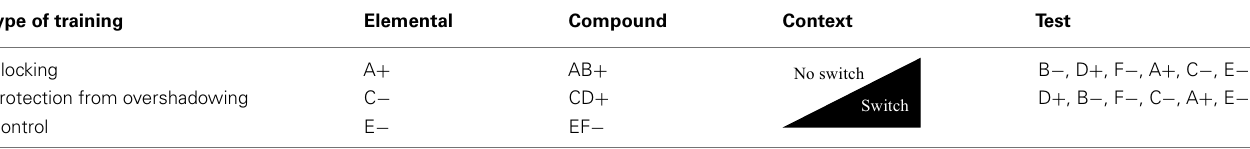
Table 1 | Conditioning contingencies.